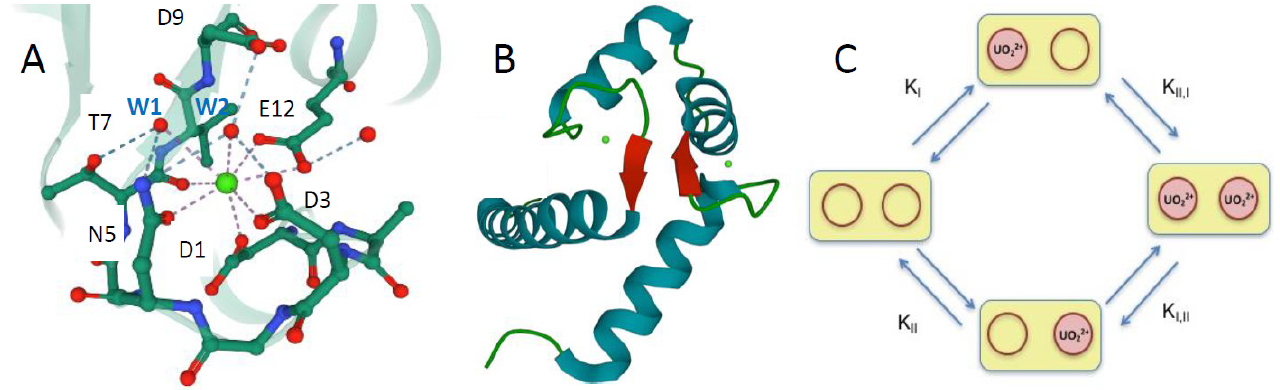
Figure 1. ( A ) Scheme of the calcium-binding site II of CaM of Paramecium tetraurelia (PDB 1EXR). Coordination of the Ca 2+ ion (in green) involves monodentate Asp1, Asp3 and Asn5 (D1, D3, and N5), the carbonyl of Thr7 (T7), bidentate Glu12 (E12) and two water molecules (W1 and W2) stabilized by hydrogen-bonding interactions (dashed blue lines); ( B ) Scheme of the N-ter domain of CaM with the intersite betasheet structure highlighted in red and calcium ions in green. ( C ) Schematic diagram of the UO 22+ binding pathways in the CaM N-ter domain, red circles represent the metal-binding sites. Microscopic binding constants are indicated for each binding step.